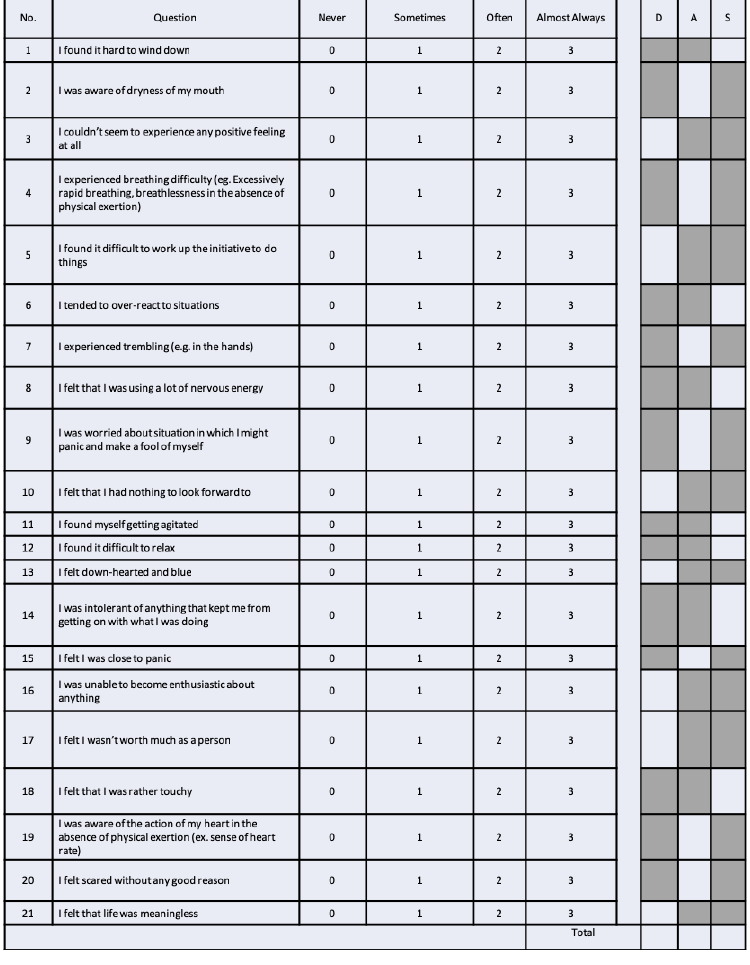
Figure 1. DASS 21 questionnaire